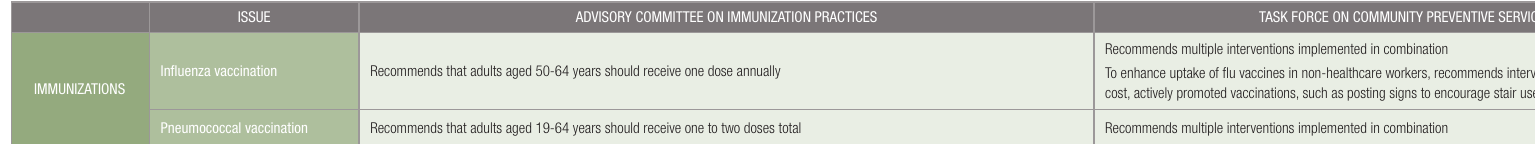
taBlE B: rECommEnDatIons rElatED to